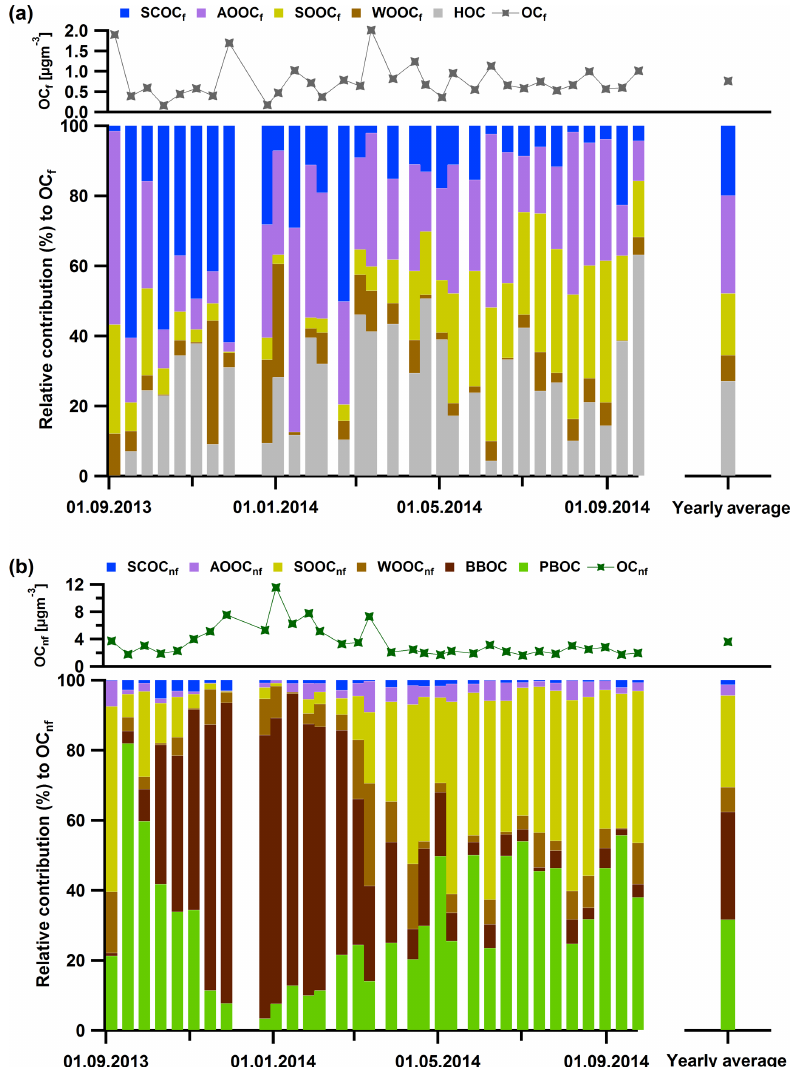
Figure 9. Relative contributions to the fossil OC per factor (PM 10 ) (a) and to the non-fossil OC per factor (PM 10 ) (b) : BBOC in dark brown, SCOC f and SCOC nf in blue, PBOC in green, AOOC f and AOOC nf in purple, SOOC f and SOOC nf in yellow, and WOOC f and WOO nf in light brown. Note that the total non-fossil concentrations (dark green markers) are on average 6 times higher compared to the fossil ones (dark grey